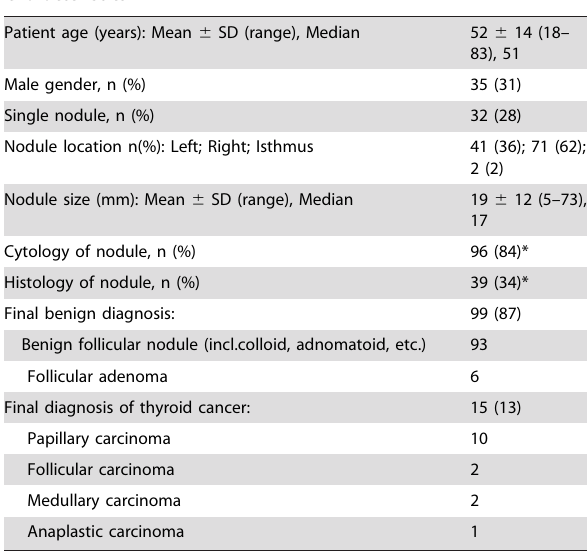
Table 1. Patient characteristics.